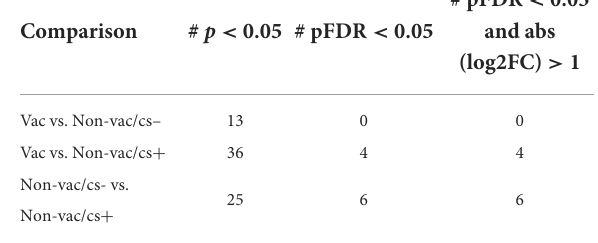
TABLE 1 Permutational multivariate analysis of variance (PERMANOVA) results based on Bray- Curtis dissimilarities. DF SumsOfSqs F. Model